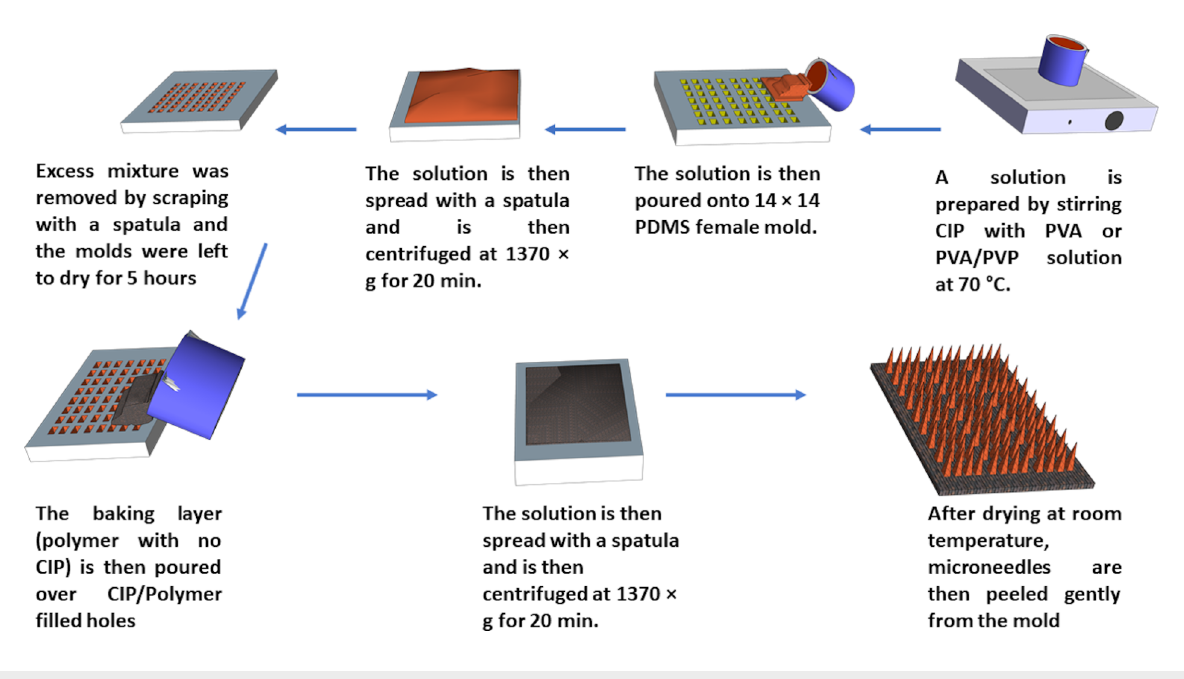
Figure 1: Microneedle fabrication using the two-layer centrifugation method. PVA/PVP or PVA gel with ciprofloxacin is stirred at 70 °C and poured on 14 × 14 PDMS mold and spread with a spatula. The mold is then centrifuged to fill the mold holes. The baking layer, which is free of the drug, is then spread over the mold, centrifuged, and allowed to dry forming polymeric